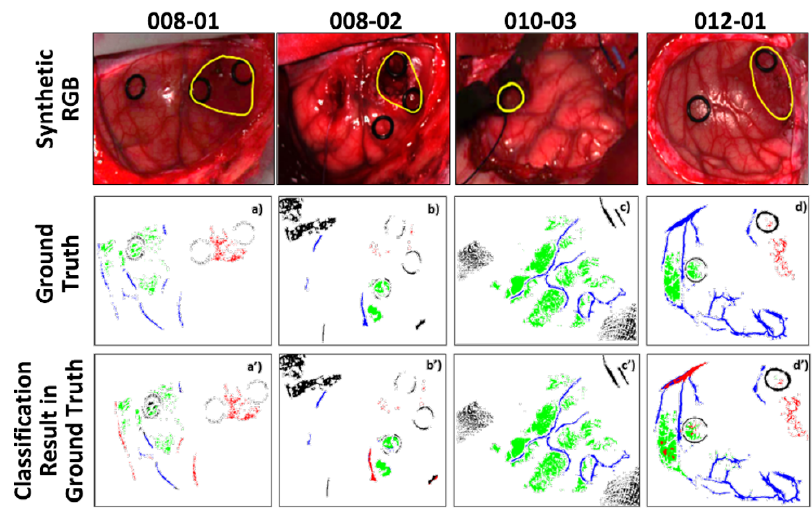
Figure 9. Multi-class classification maps of four of the test hyperspectral (HS) images obtained with the 3D–2D hybrid CNN model. ( a – d ) depict the predicted map of their respective ground truth, ( a’ – d’ ) Normal, tumor tissue and blood vessels are represented in green, red, and blue colors, respectively, while the background is represented in